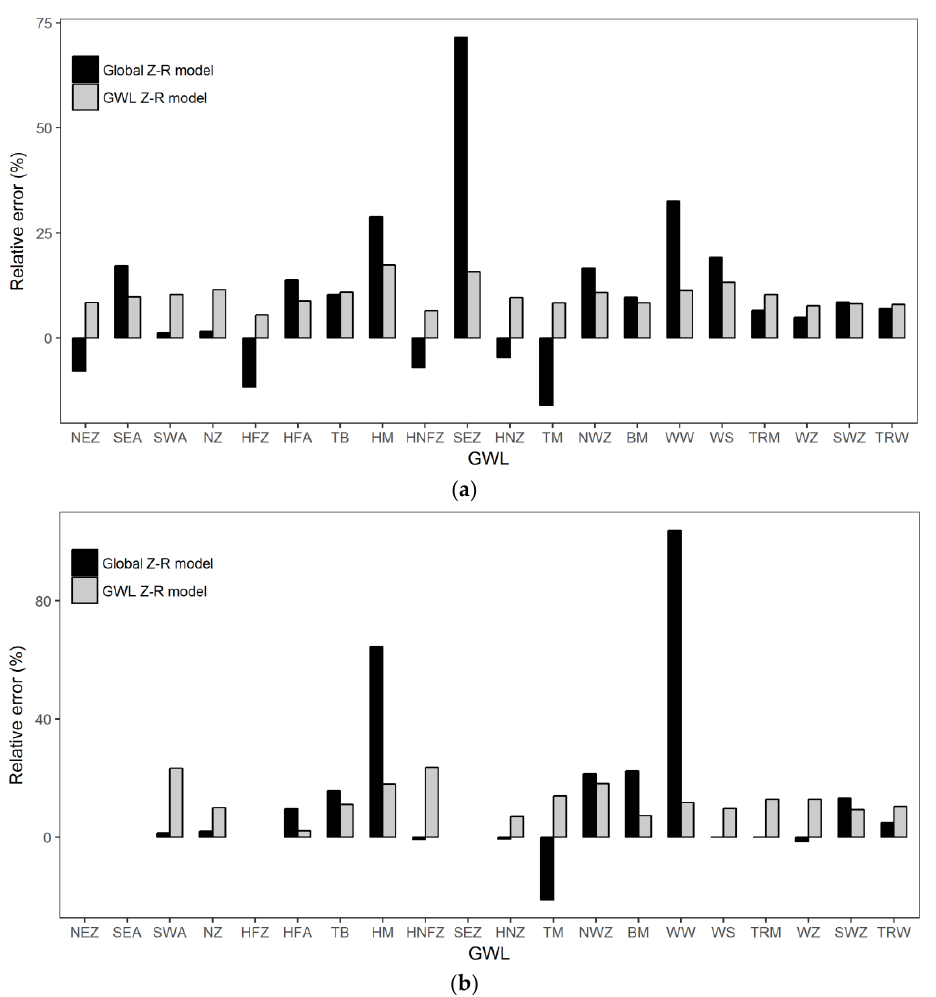
Figure 8. Relative error (RE) of the accumulated rain amount estimated by the global Z – R model (black) and the GWL Z – R model (grey) for ( a ) stratiform rain and ( b ) convective rain.